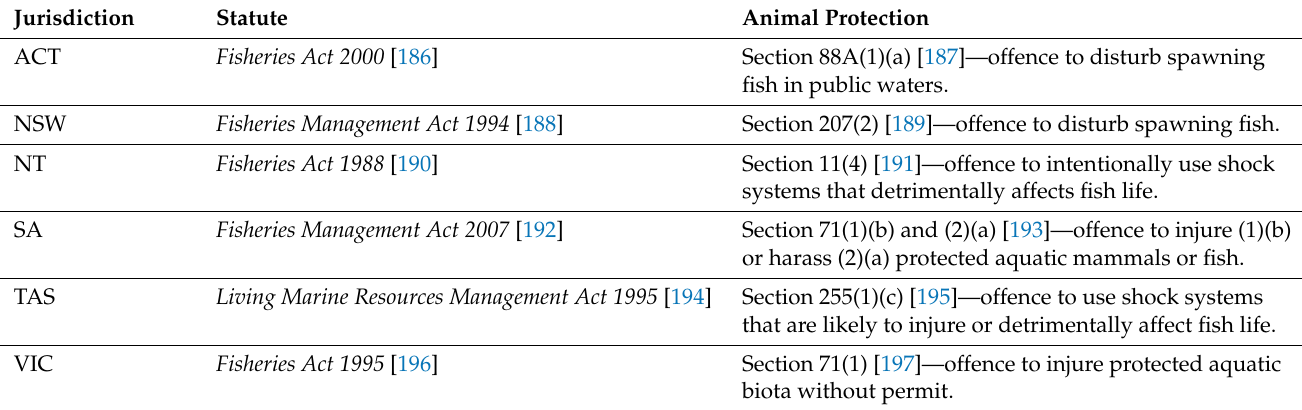
Table 12. Fish statutes and the corresponding animal protection provisions per each Australian state and territory excluding QLD and WA, as there is no animal protection awarded in those statutes. Offences have been paraphrased for brevity.